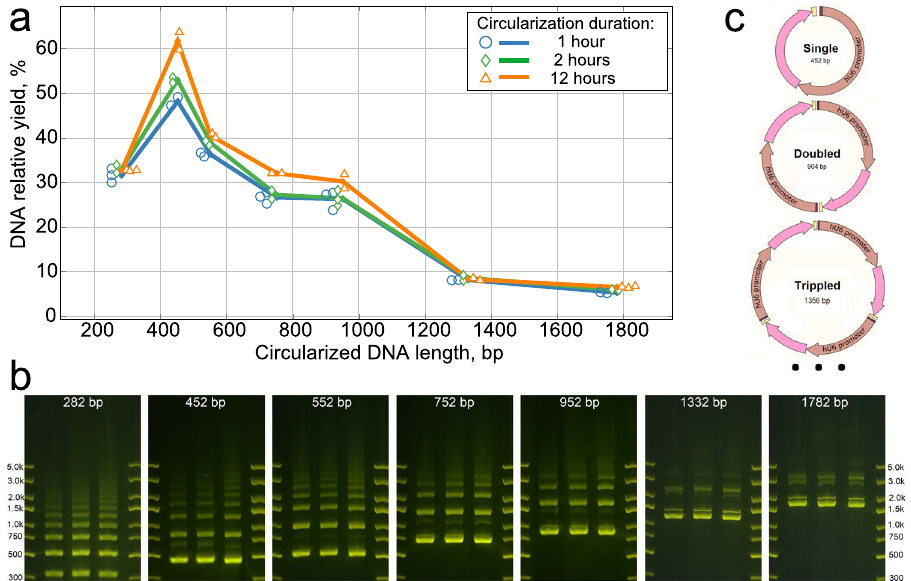
Fig. 2 Circularization yield and concatemer proportions. a Relative yield at a range of input DNA lengths at 1, 2 and 12 h of circularization. The line nodes represent the averages of n = 2 – 3 independent reaction samples; the dots show individual data samples for the nodes, horizontally offset for visibility. b Gel electrophoresis combination image. In each subplot, Lane 1 = 1 h, Lane 2 = 2 h, and Lane 3 = 12 h of circularization. The quantity of DNA was normalized to 300 ng per lane in subplots 282 – 952 bp. To avoid overload due to the small number of bands, DNA quantity was normalized to 150 ng per lane for the 1332 and 1782 bp subplots. The lanes in each subplot are a subset of lanes from a same single gel plate for each Circular Vector length, cropped only to reduce the number of lanes without any image enhancement; the complete gel photographs are available in the Supplementary Data. c Schematic diagram of self- circularization and the joining of repeated multiple